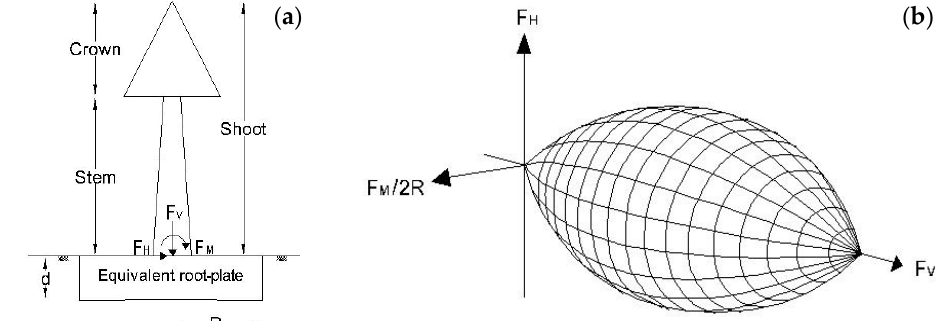
Figure 2. Windthrow model development. ( a ) Schematic tree representation under general loading condition and ( b ) failure load surface in the F V -F H -F M /2R space (after [52]).